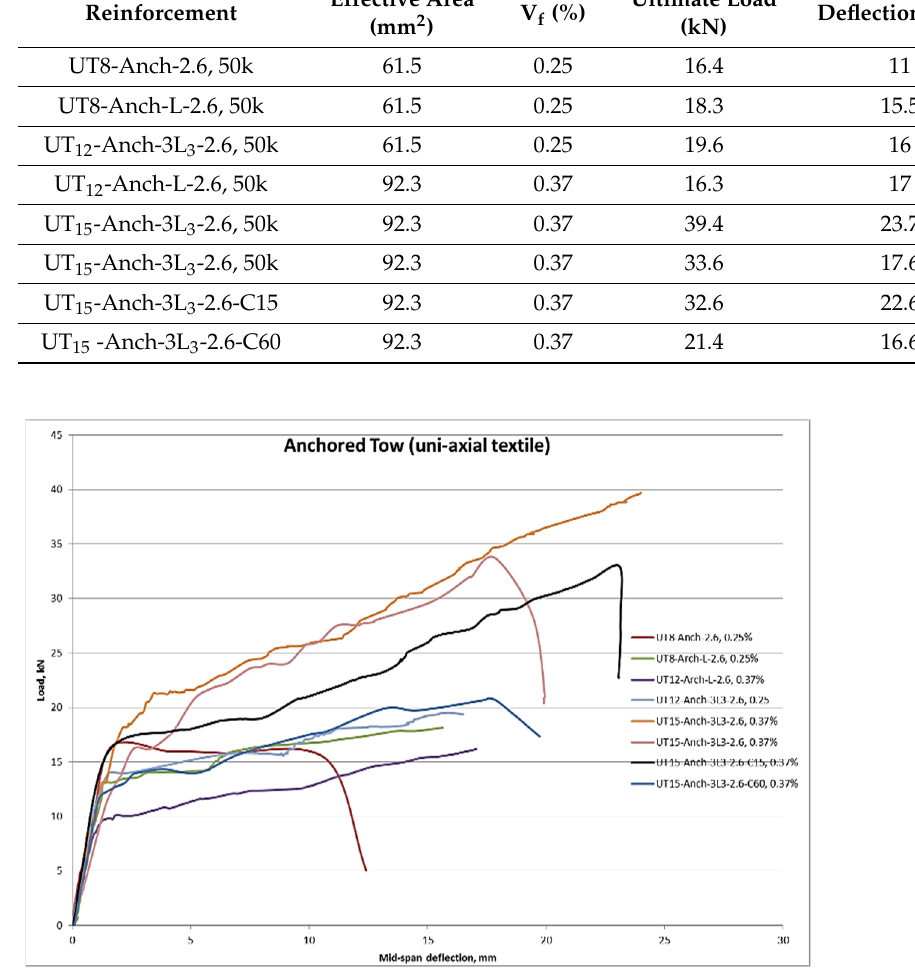
Figure 12. Mid-span load-deflection of anchored end uni-axial TRC beams.